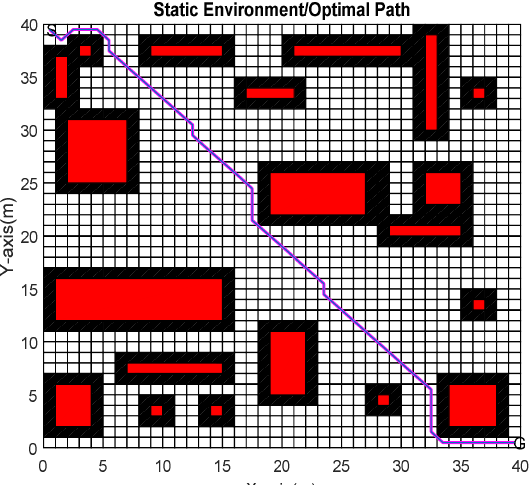
Fig. 22. Best Path found by Modified ACO for Experiment 3 .